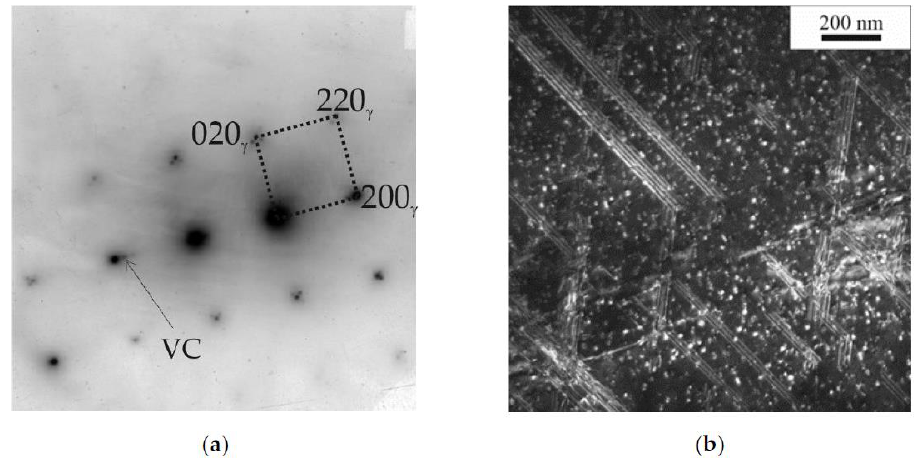
Figure 4. ( a ) SAED pattern and ( b ) dark-field image of the 0.30C-13Cr-15Mn-3Si-1V steel in the Figure 4. ( а ) SAED pattern and (b) dark-field image of the 0.30C − 13Cr − 15Mn − 3Si − 1V steel in the 223 reflection of VC carbide. Treatment: quenching (Q) from 1100 ° С ; aging (A) at 720 ° С , for 6 hours; 224 reflection of VC carbide. Treatment: quenching (Q) from 1100 ◦ C; aging (A) at 720 ◦ C, for 6 h; cold cold deformation (CD) ~4% ( γ → ε transformation), and heating (H) to 500° С ( ε → γ transformation). 225 deformation (CD) ~4% ( γ → ε transformation), and heating (H) to 500 ◦ C ( ε → γ transformation). The The zone axis [001] γ ,VC. zone axis [001] γ ,VC .